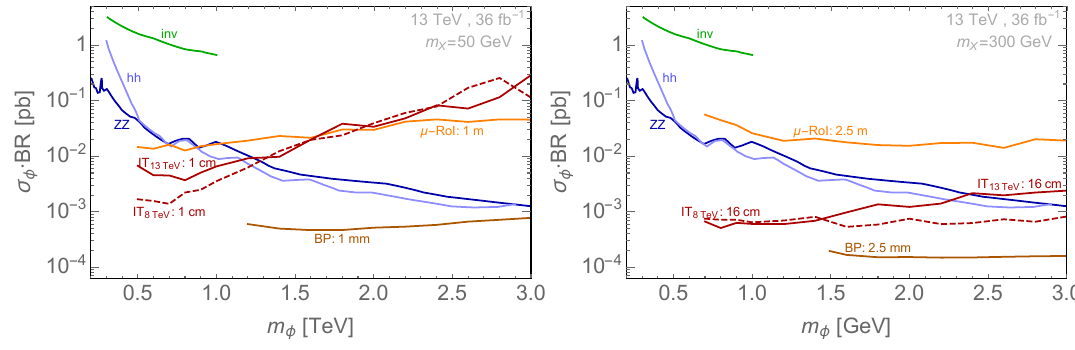
Figure 1 . Summary of the cross section times branching ratio probed by 13 TeV searches with L now = 36 fb (cid:0) 1 . Dark blue for (cid:30) ! ZZ , dark green for (cid:30) ! inv., light blue for (cid:30) ! hh . For (cid:30) ! XX we consider X ! jj with di(cid:11)erent values of the X lifetimes and left and right panels correspond to m X = 50 GeV and m X = 300 GeV, respectively. In the plot we select three representative values for these lifetime regimes which maximize the reach of a given search. Orange is the ATLAS (cid:22)